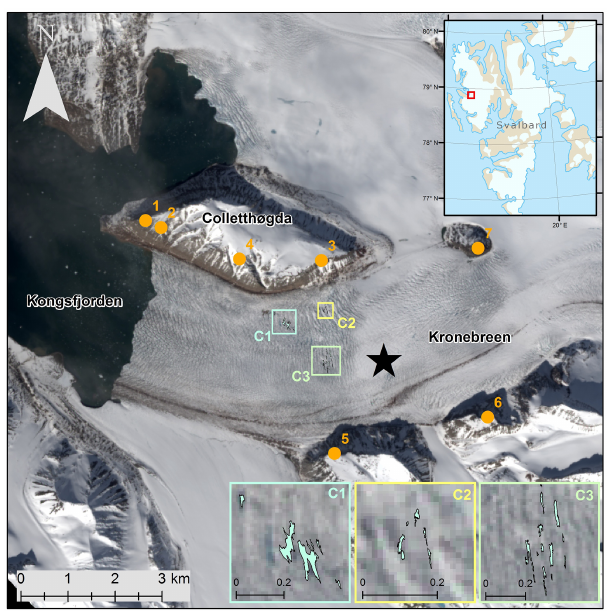
Figure 1. Kronebreen, a tidewater glacier situated in Kongsfjorden, Svalbard. The glacier consists of an 8km-long tongue fed by two ice fields, Holtedahlfonna and Infantfonna. Numbered locations refer to the 2014 time-lapse camera sites, the star marks the location of the borehole drill site, and the coloured boxes refer to the three lake clusters visible from camera sites 3 and 5. Landsat imagery taken on 11 June